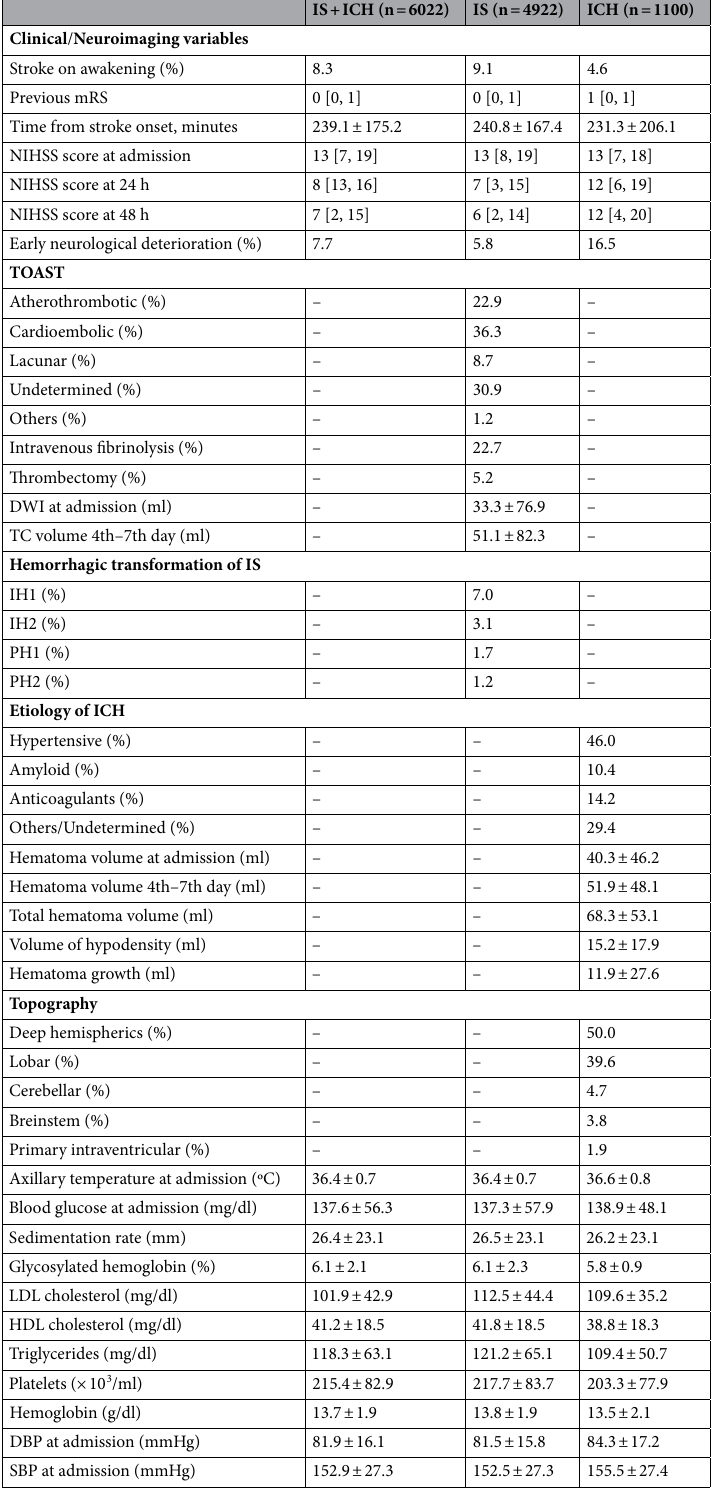
Table 2. Clinical and neuroimaging variables of the experimented dataset of patients summarized by